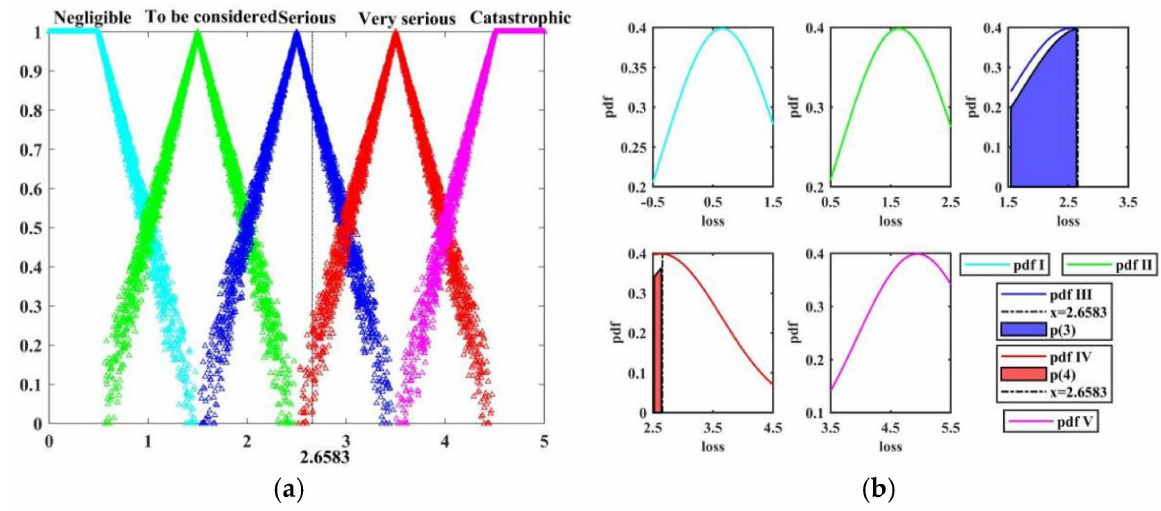
Figure 7. Comprehensive evaluation results ( C ). ( a ) Triangular cloud model, ( b ) probability density function